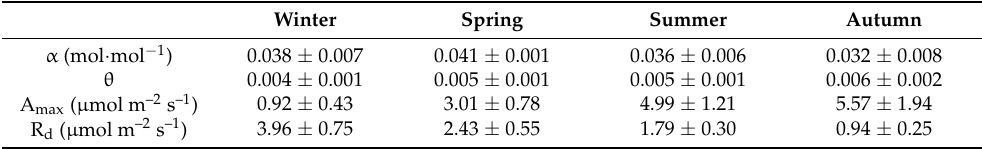
Table 1. Average values ( ± standard error) of quantum efficiency ( α ), shape parameter ( θ ), maximum net assimilation rate (A max ), and dark respiration rate (R d ) of Zelkova serrata (Thunb.) Makino across different